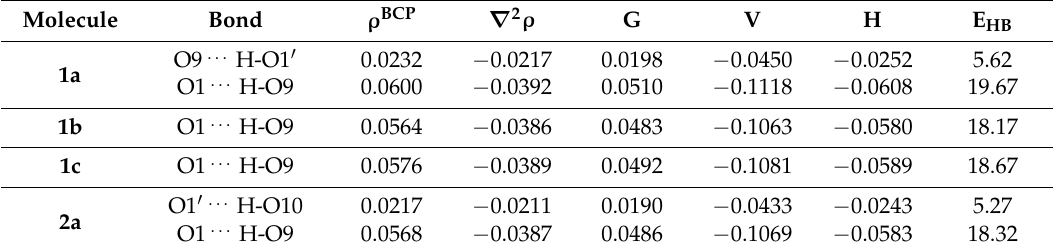
Table 10. Atoms-in-molecules parameters for 1 and 2 . Electron density at the critical point ρ BCP (a.u), its Laplacian ∇ 2 ρ (a.u.), electron kinetic energy density G (a.u.), ptential energy density V (a.u.),